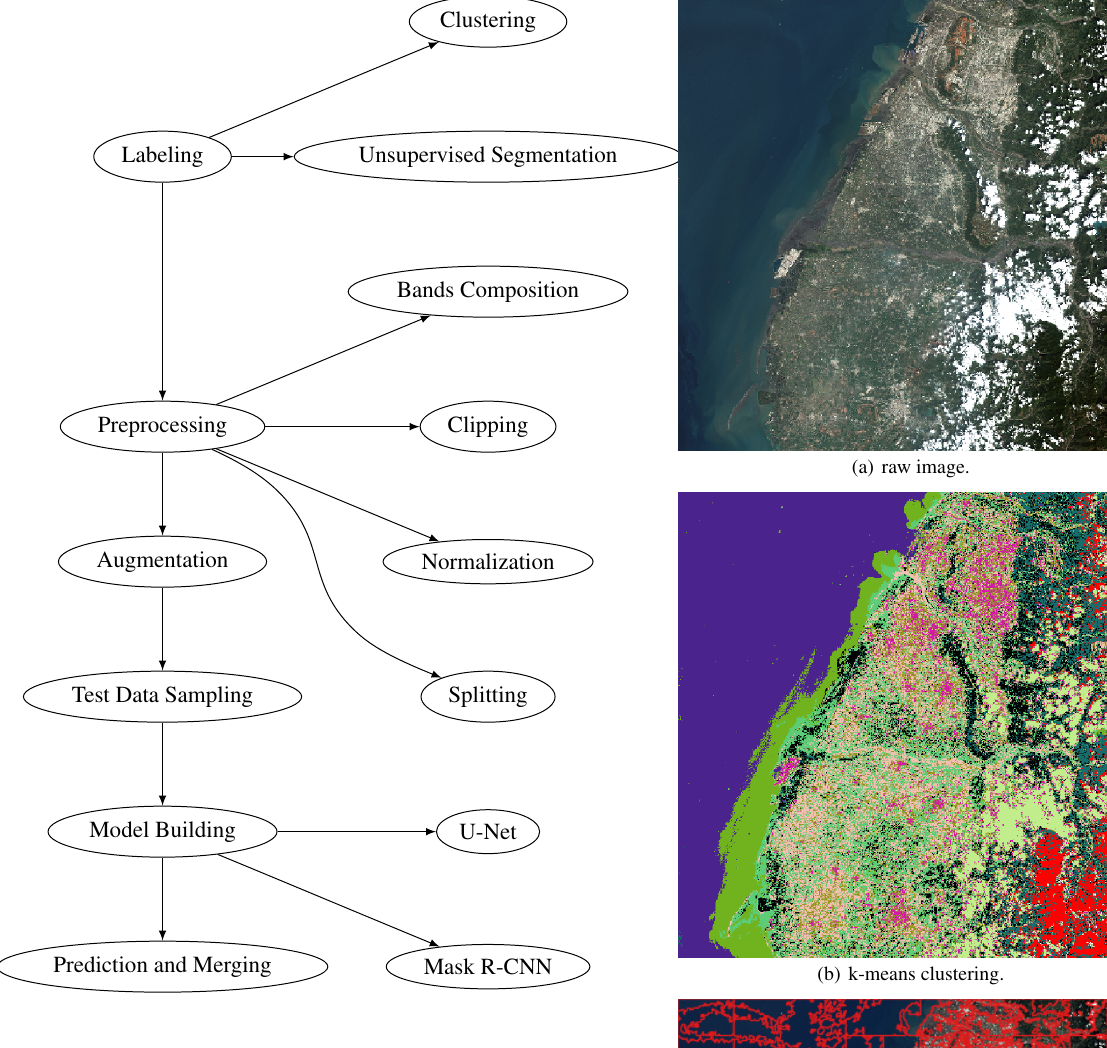
Figure 2. Main Process.